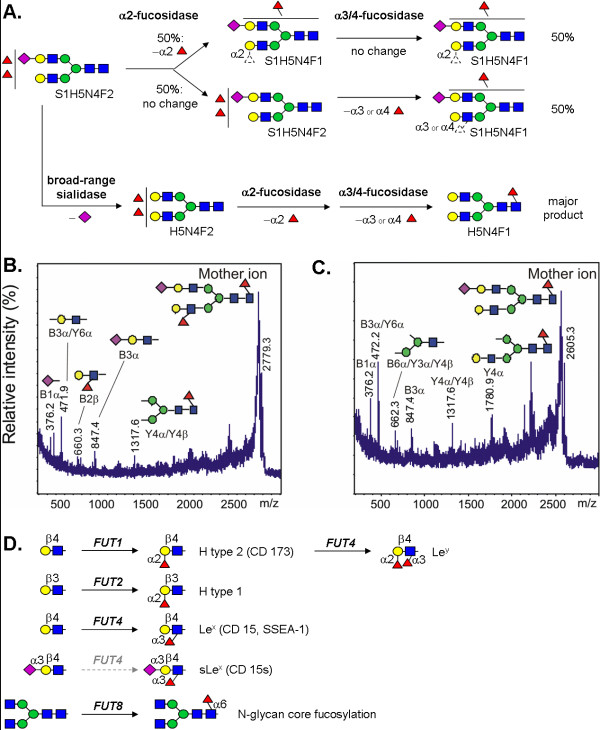
Analysis of major complex fucosylated N-glycans of hESC. A. The major sialylated N-glycan signal with complex fucosylation feature (S1H5N4F2) was subjected to exoglycosidase sequencing with linkage-specific fucosidases and broad-range sialidase. As outlined in the reaction scheme, the signal was shown to be an approximately 1:1 mixture of α1,2- and α1,3-/α1,4-fucosylated biantennary complex-type N-glycans with core fucosylation. B. and C. The acidic N-glycan fraction was permethylated and subjected to MS/MS fragmentation. Both S1H5N4F2 (B.) and S1H5N4F1 (C.) produced fragments that supported the structure assignments as indicated in the schematic drawings. D. The studied hESC lines were shown to express four of the known human fucosyltransferases. Minimal glycan acceptor and product specificities for the encoded enzymes are shown in the schematic drawing.